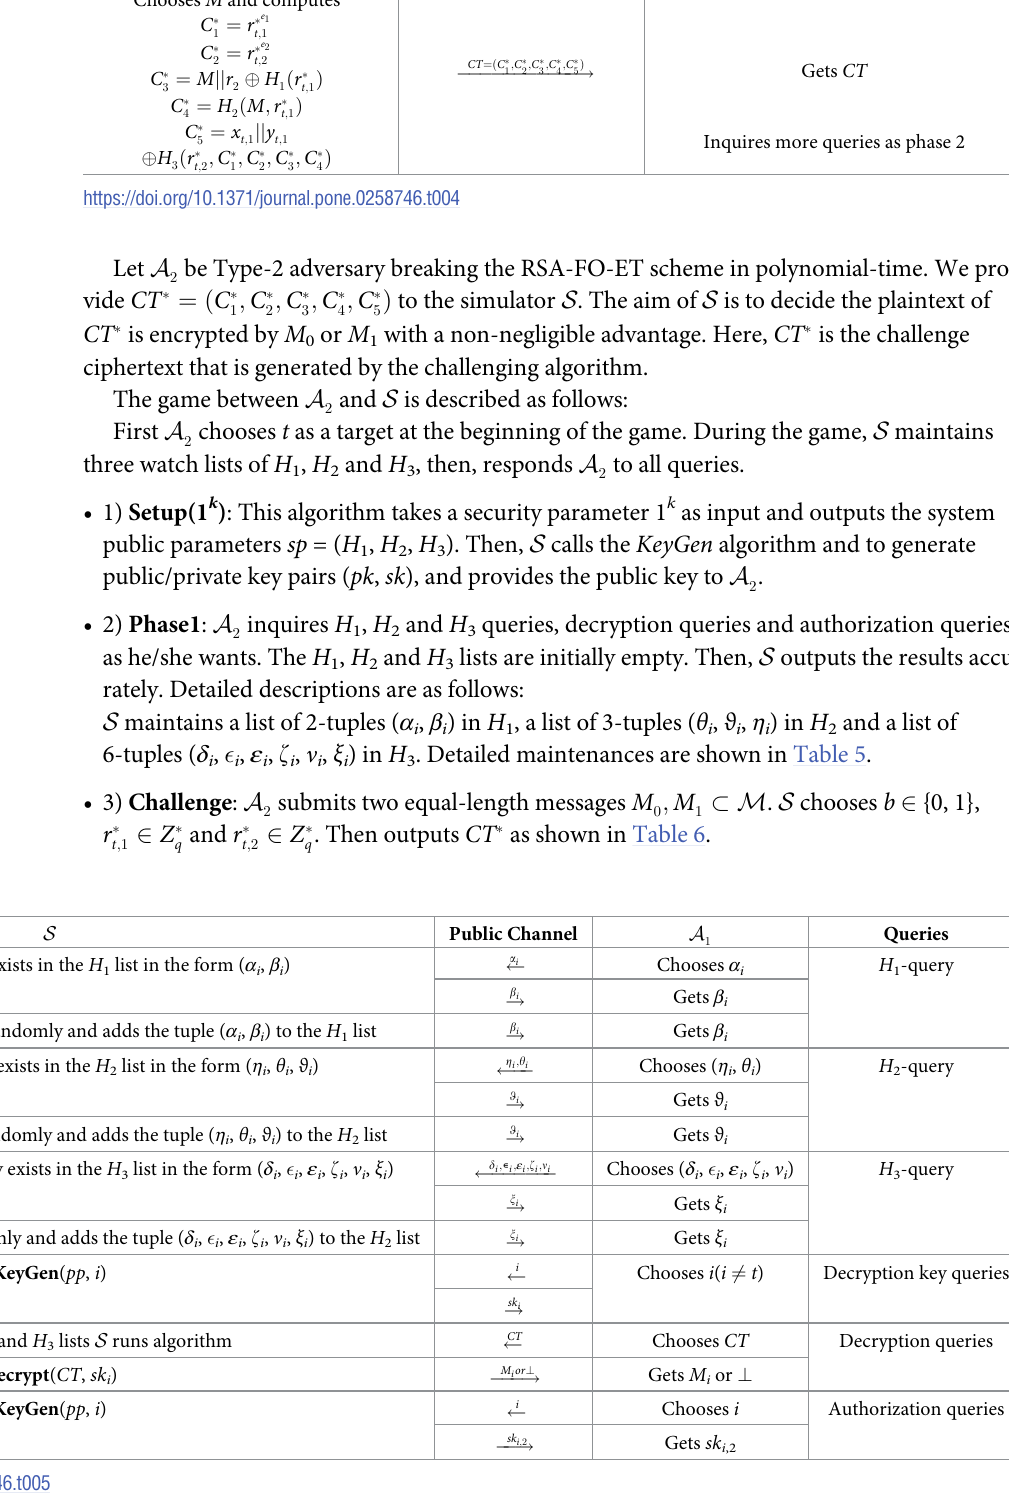
Table 4. Challenge. S Public Channel A Chooses M and computes